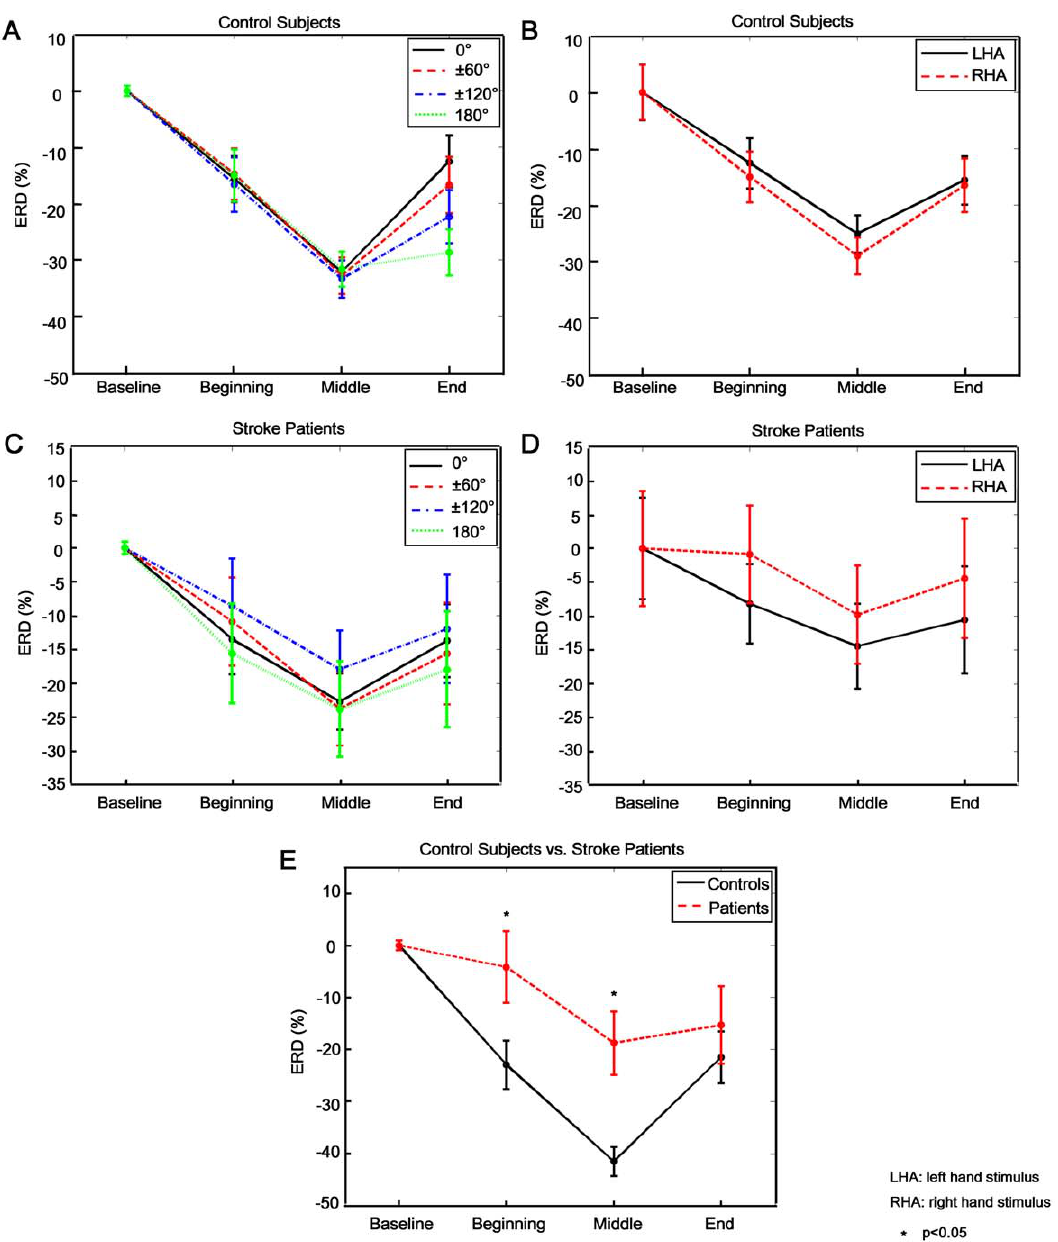
Figure 5. Event-related desynchronization in beta band (beta-ERD). A and B: Beta-ERD lines at Pz electrode for control subjects were illustrated with respect to ANGLE and HAND factors respectively. C and D: Beta-ERD lines at Pz electrode for stroke patients in regard to ANGLE and HAND factor respectively were shown. E: The comparison of beta-ERD between control subjects and stroke patients was illustrated. All ERD/ERS indexes were based on normalization with Baseline (i.e., ERD/ERS index in its corresponding sub-stage minus Baseline ERD/ERS index), thus ERD/ERS index in Baseline was 0%. And, ERS/ERD indexes were negative in other three sub-stages, thus significant ERD was observed in all subjects. Similar with ERP results, no significant difference of beta-ERD between 60 u vs. 300 u (p=0.278), 120 u vs. 240 u (p=0.352) was observed for all subjects. Thus only four beta-ERD lines of 0 u , 6 60 u , 6 120 u and 180 u were illustrated in A and C. doi:10.1371/journal.pone.0042922.g005 and CP2) in control subjects showed significant beta-ERD (Figure 6D). In contrast, stroke patients showed less brain areas (FC1, Cz, CP2, P4 and O2) with beta-ERD (Figure 6H). In addition, significant HAND effect (F(1,20) = 4.863, p= 0.039) and its interaction with GROUP (F(1,20) = 2.141, p= 0.046) (F(1,20) = 2.272, p = 0.147) (Figure 5E). Significant effect of were also observed. Specifically, stroke patients showed overall REGION (F(12,240)= 13.425, p , 0.001) and its interaction with lower beta-ERD for right hand (affected) than that for left hand GROUP (F(12,240)= 2.746, p = 0.002) were found. Most (p = 0.018) (Figure 5D). However, beta-ERD in control group frontal-central areas (F3, Fz, F4, FC1, FC2, C3, Cz, C4, CP1